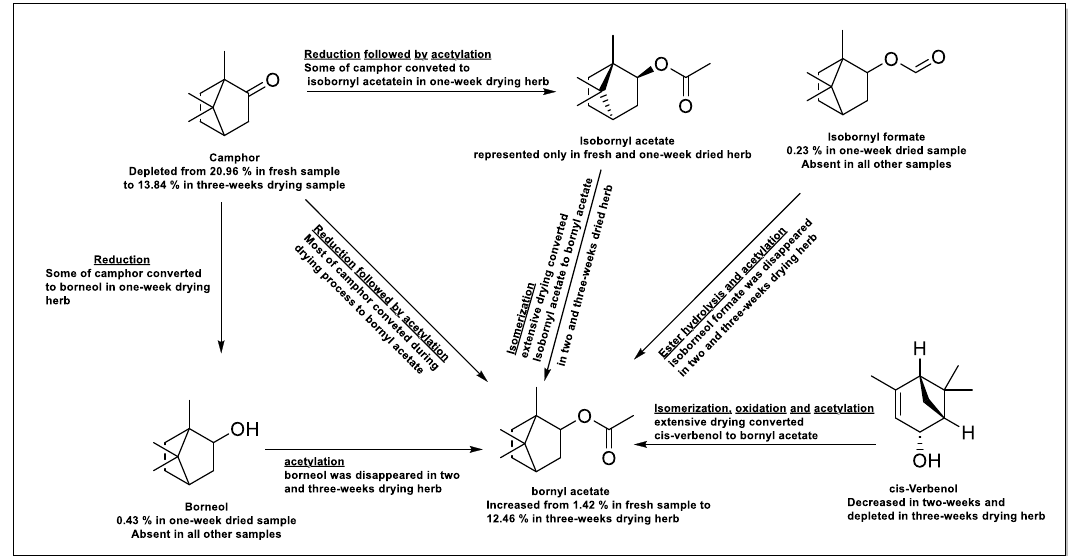
Figure 2. A plausible pathway for envisaged biotransformations within rosemary oil during the three-weeks long drying period.